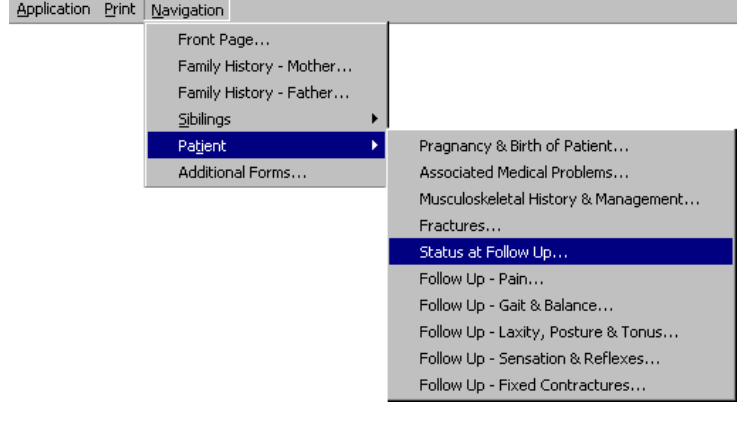
FIGURE 4. Navigation